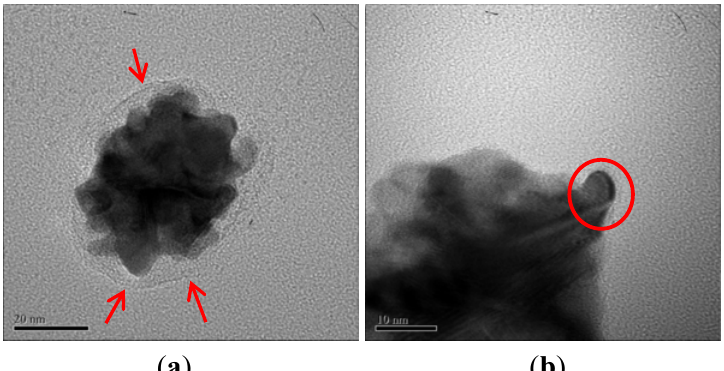
Figure 4. TEM images of the gold nanoparticle with DNA matrix.